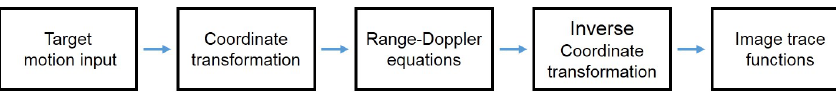
Figure 3. Steps for deducing image trace functions